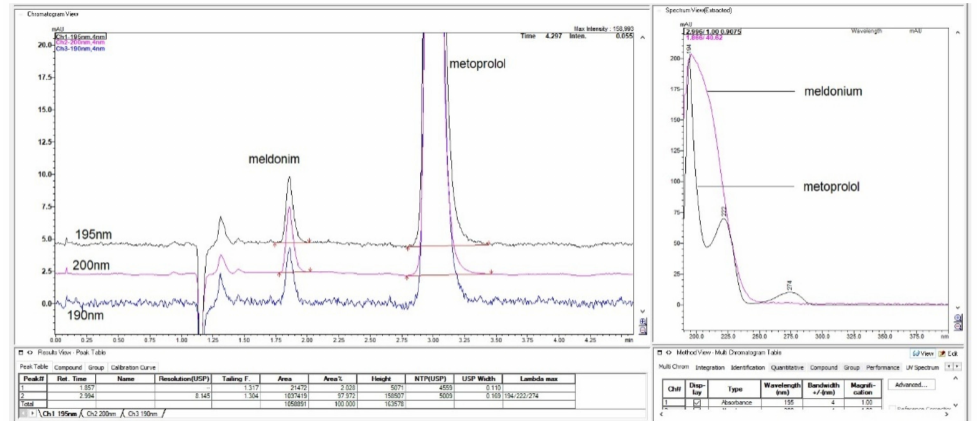
Figure 8. Column LiChrospher CN 125 × 4 mm baseline noise dependence of wavelength with mobile phase ingredient diluted TFA. While the baseline was remarkably different, changes in meldonium peak were quite small, and no more concave shaped as with ammonium phosphate used in mobile phases.